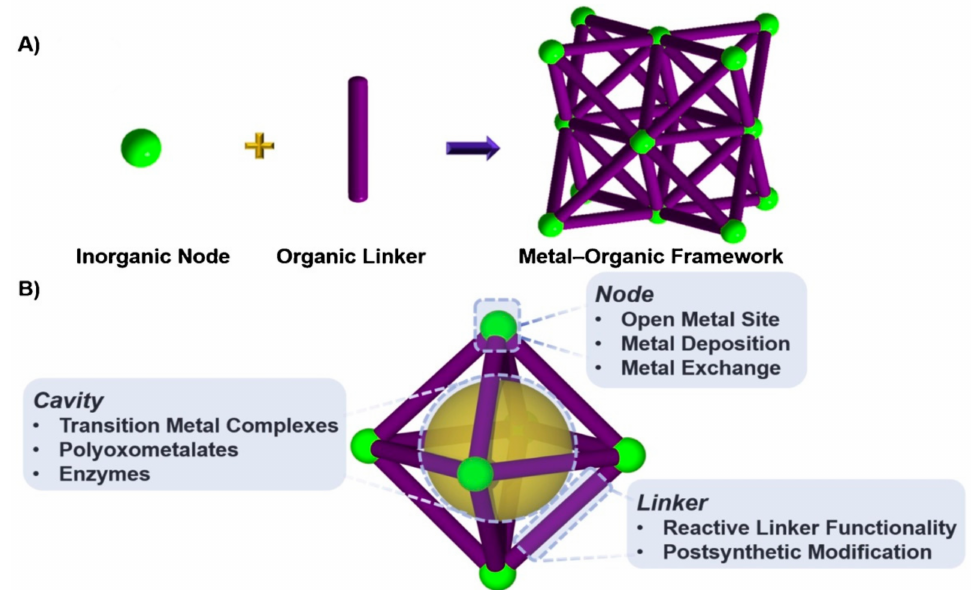
Figure 6. Special features of metal-organic frameworks: ( A ) Typical MOFs synthesis comprising inorganic nodes and organic linkers. ( B ) The accessibility of MOFs by modifying the node, linker, and content of the cavity. Reproduced with permission Ref. [107]. Copyright 2019 Elsevier.